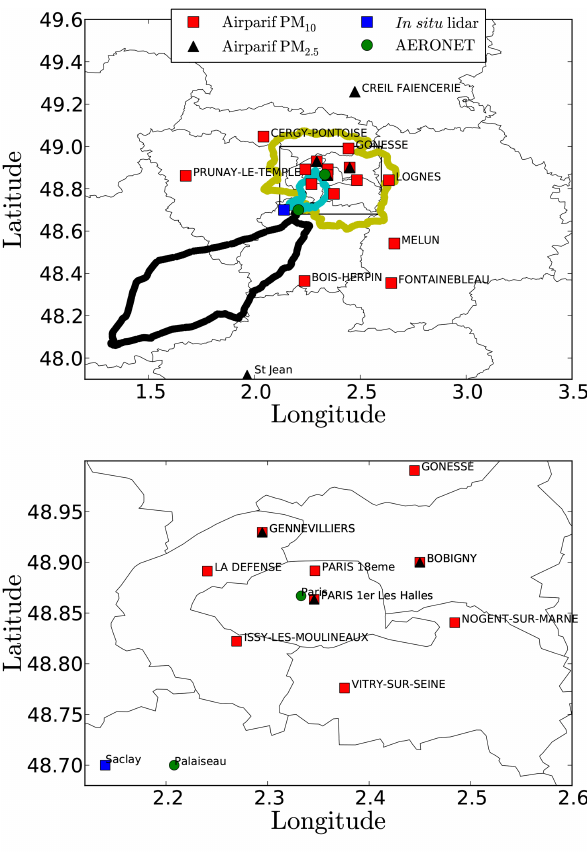
Fig. 1. The blue square shows the location of the ground-based in situ lidar station, the red squares (black triangles) show the locations of Airparif stations for PM 10 (PM 2 . 5 ) measurements and the green circles show the locations of AERONET stations. The thick black track shows that of the GBML on 1 July 2009. The thick yellow and cyan tracks show those two followed by GBML on 26 July 2009. The rectangular area is detailed in the bottom